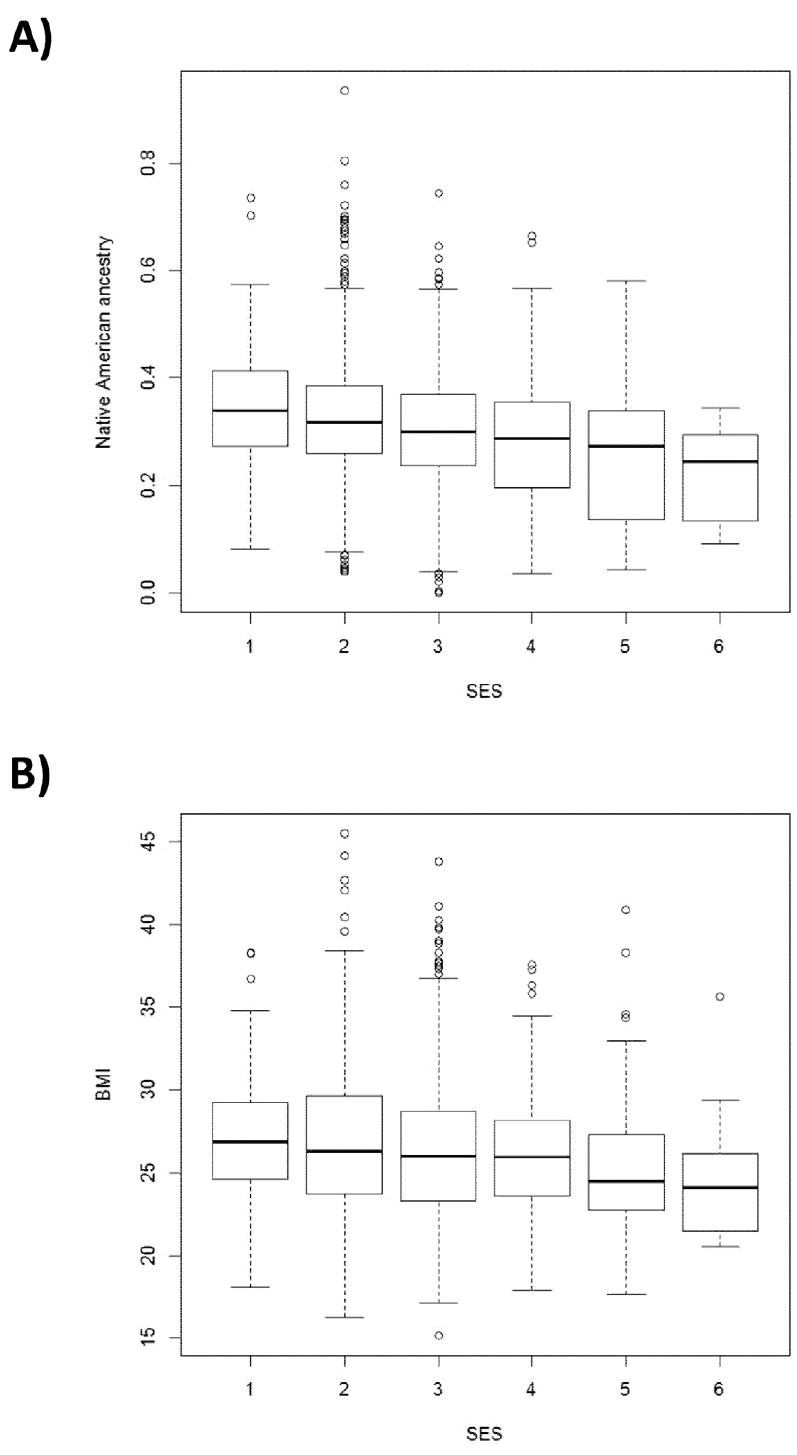
Figure 2. Box plots of (A) Native American ancestry and (B) BMI for socioeconomic status bands 1 to 6 in the Antioquian study sample.